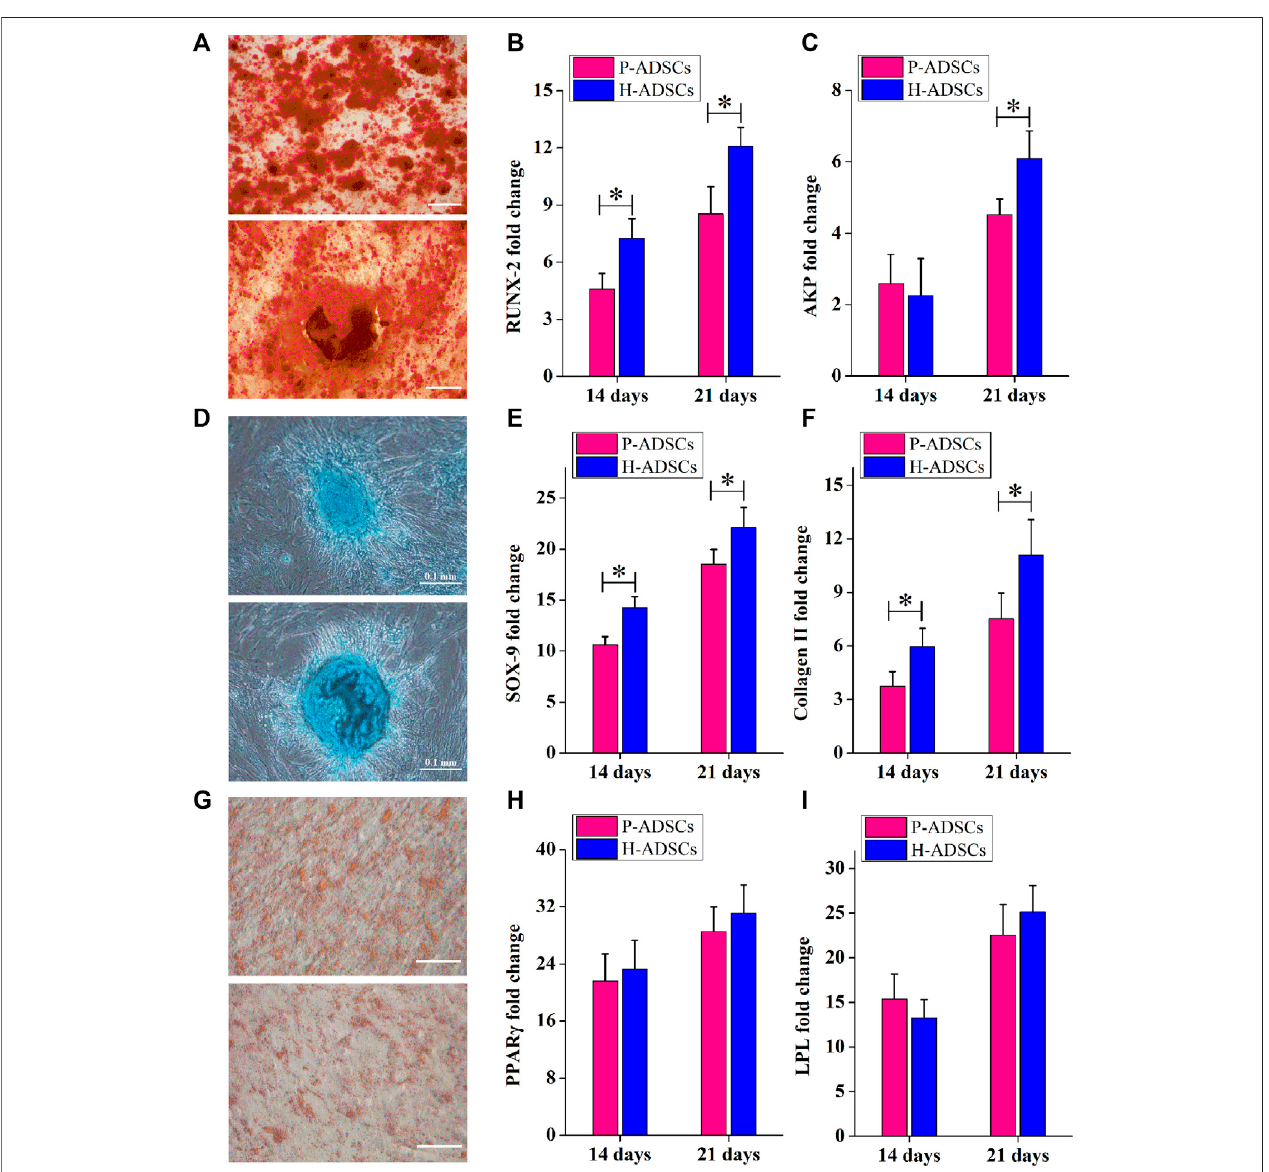
FIGURE 3| Comparison of the differentiation potentialof P-ADSCs and H-ADSCs (A) : Osteogenic differentiation ofP-ADSCsor H-ADSCscultivated in 5% hPL at passage 5, after different inductions and stained with alizarin red. Representative images are shown. Scale bars = 100 μ m. (B,C) : Levels of osteogenic-related genes determined by RT-PCR. n = 7; * p < .05 determined by the Wilcoxon-Mann-Whitney nonparametric test. (D) : Chondrogenic differentiation of P-ADSCs or H-ADSCs cultivated in 5% hPL at passage 5, after different inductions and stained with Alcian blue. Representative images are shown. Scale bars = 100 μ m (E,F) : Levels of chondrogenic-related genes determined by RT-PCR. n = 7; * p < .05 determined by the Wilcoxon-Mann-Whitney nonparametric test (G) : Adipogenic differentiation of P-ADSCs or H-ADSCs cultivated in 5% hPL at passage 5 after different inductions and stained with oil red O. Representative images are shown. Scale bars = 100 μ m. (H – I) : Levels of adipogenic-related genes determined by RT-PCR ( n = 7).